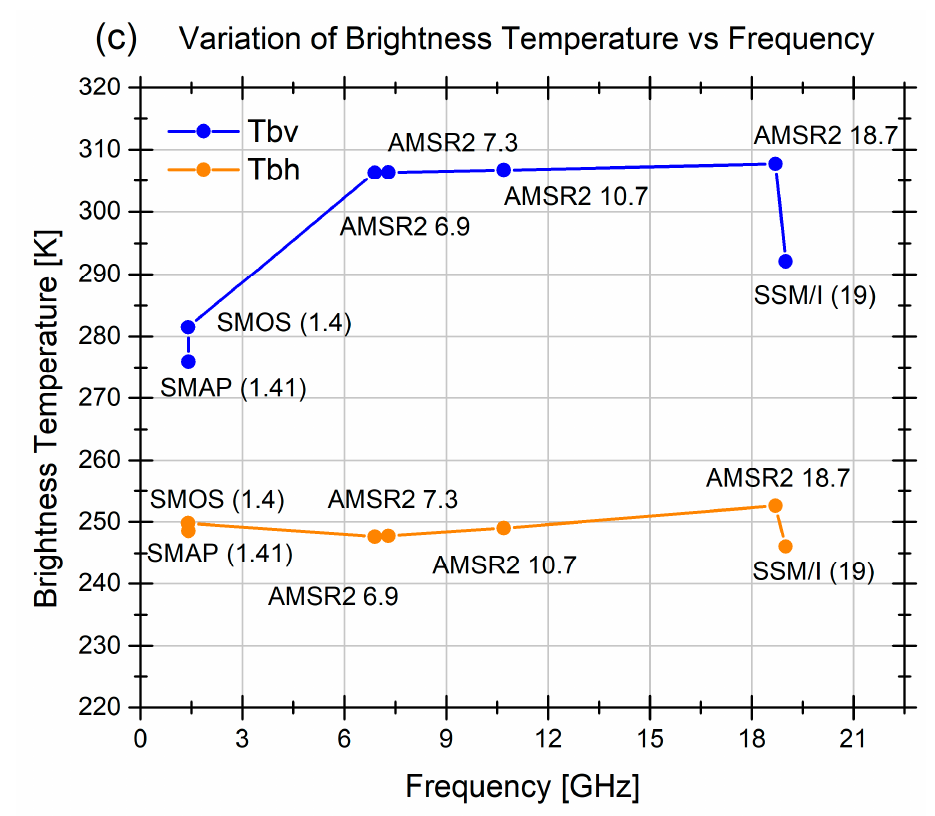
Figure 9. Simulated brightness temperature versus satellite: ( a ) LST; ( b ) incident angle; ( c ) frequency for V and H.